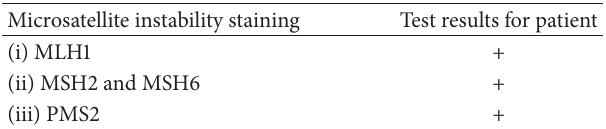
Table 4: MSI test results for the Asian patient. A positive MSI indicates normal